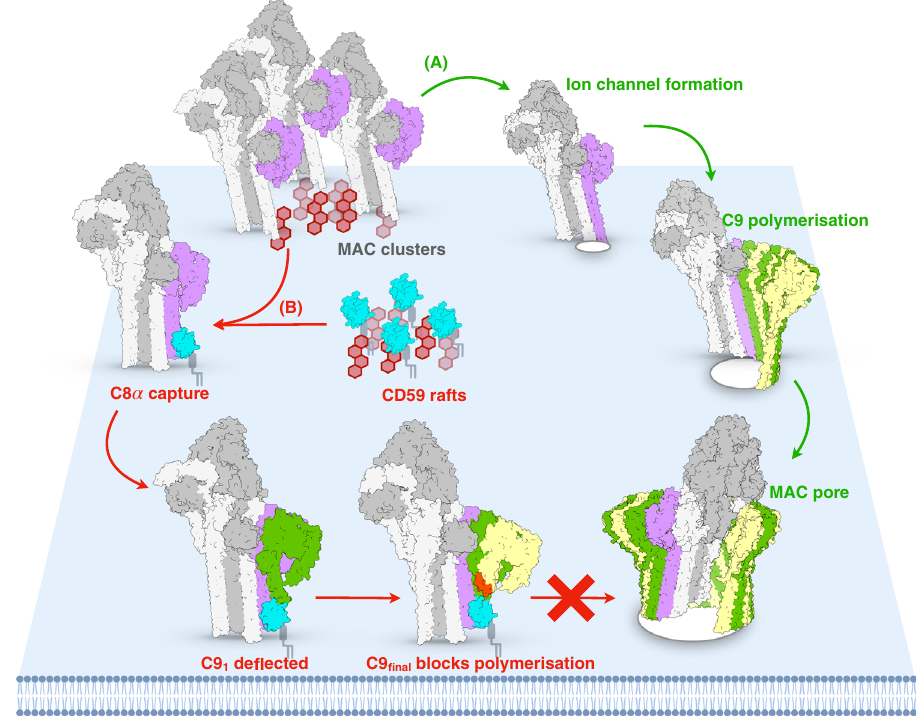
Fig. 6 | Schematic of MAC assembly and its inhibition by CD59. A MAC assembles on cholesterol-rich microdomains (red hexagons) in the plasma membrane.WhileC7anchorsthegrowingMAC,C8 β thinsthebilayerandprimes the membrane for rupture by C8 α (pink). C9 joins the assembly, undergoing discrete structural transitions to form the pore. The MACPF domain of soluble C9 makes an initial contact and aligns the central β -sheet. The pore-forming β -hairpins extend sequentially. TMH1 is followed by TMH2, which allow C9 polymerizationtocompletetheMACpore. B CD59isaGPI-anchoredcellsurface